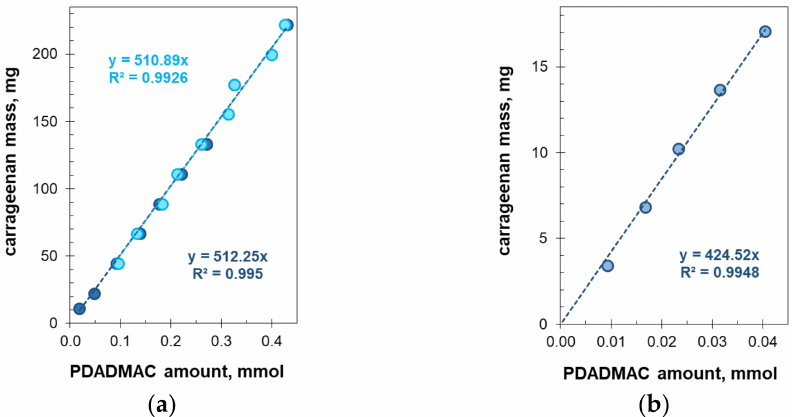
Figure 8. The mass of carrageenan vs. the molar amount of polyDADMAC at the equimolar charge ratio. ( a ) Data were obtained with the external light sensor in reflection mode (light blue) and transmission mode (dark blue). ( b ) Data were obtained with the immersion optical